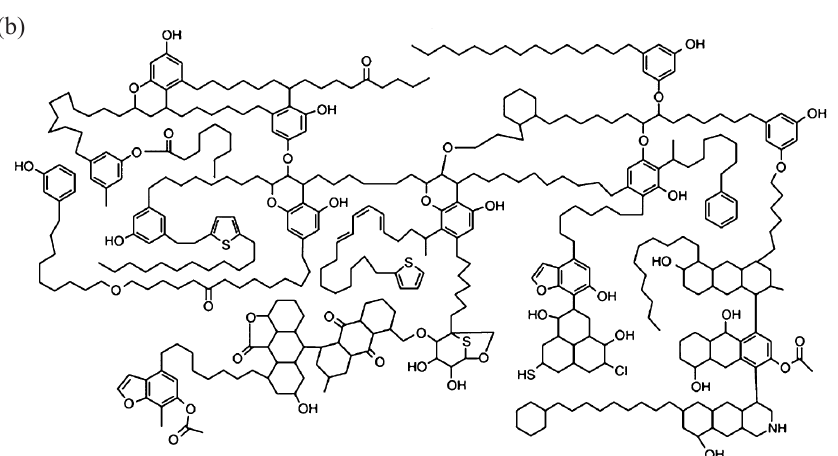
Fig. 1. Molecular model of coal (a) [3] and oil shale (b)